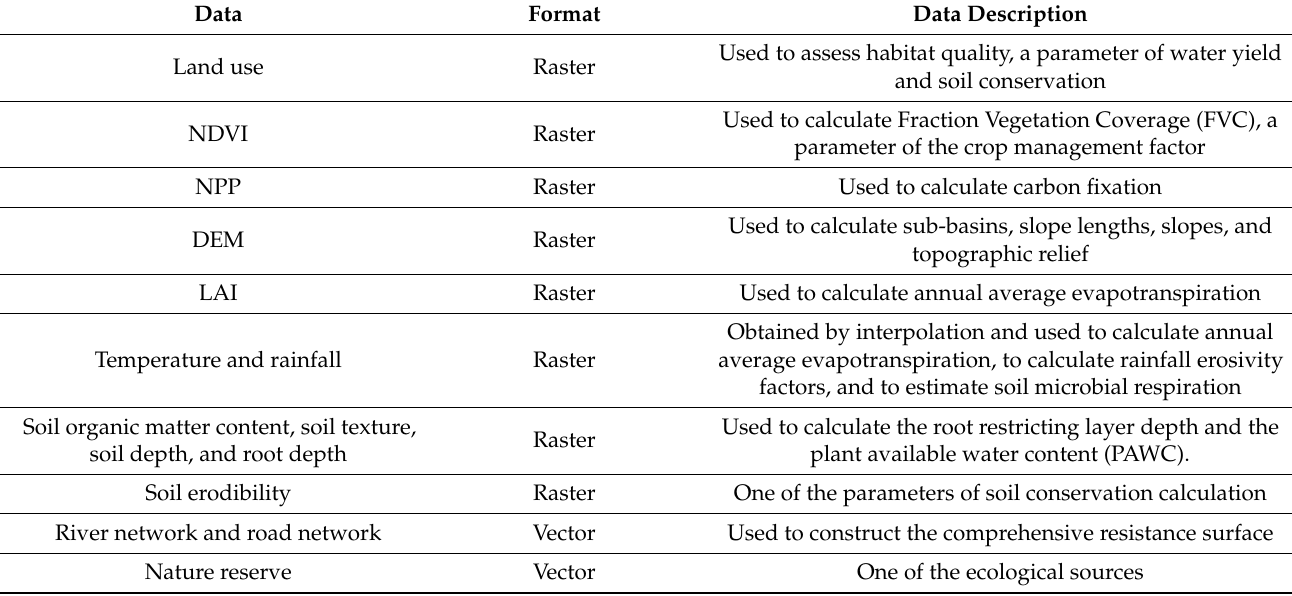
Table 2. Basic introduction of research data.